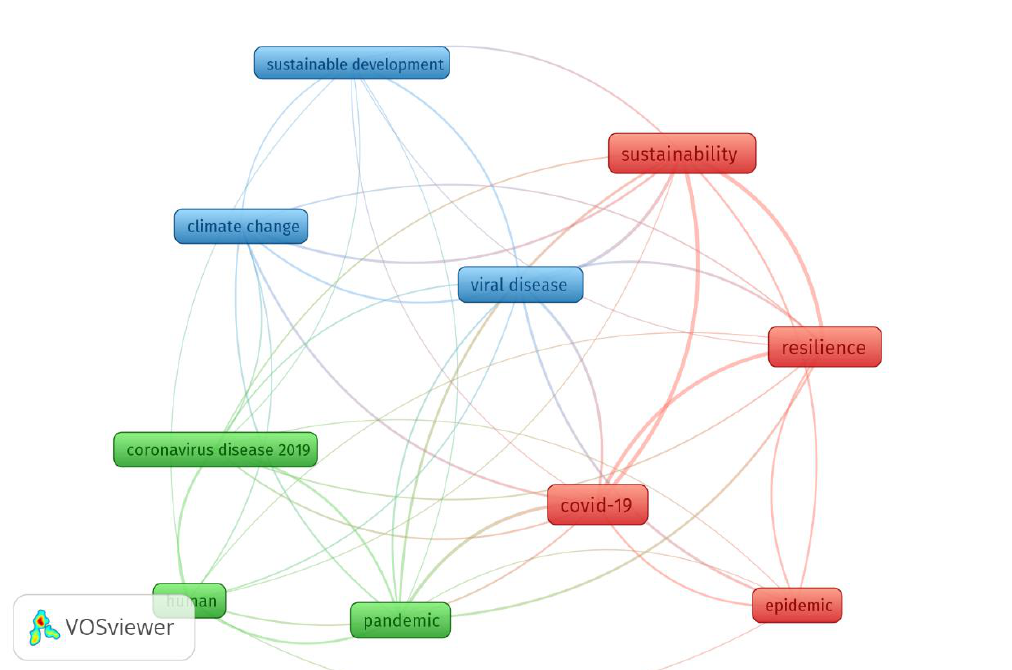
Figure 3: Text Analysis Binary on Title and